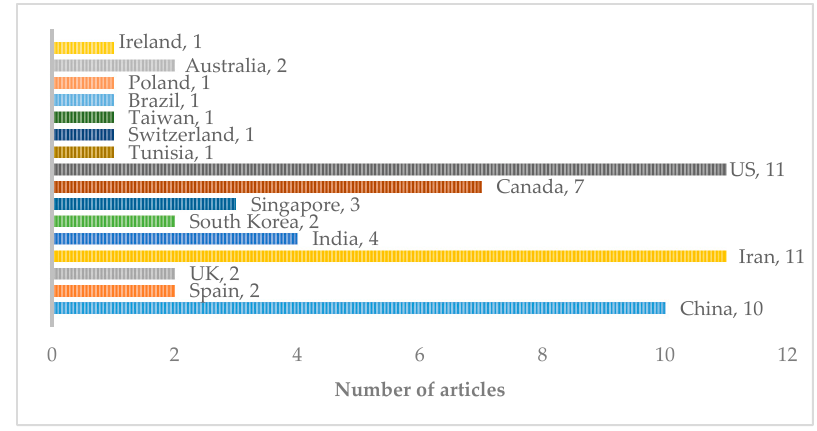
Figure 4. Distribution of empirical data by country.